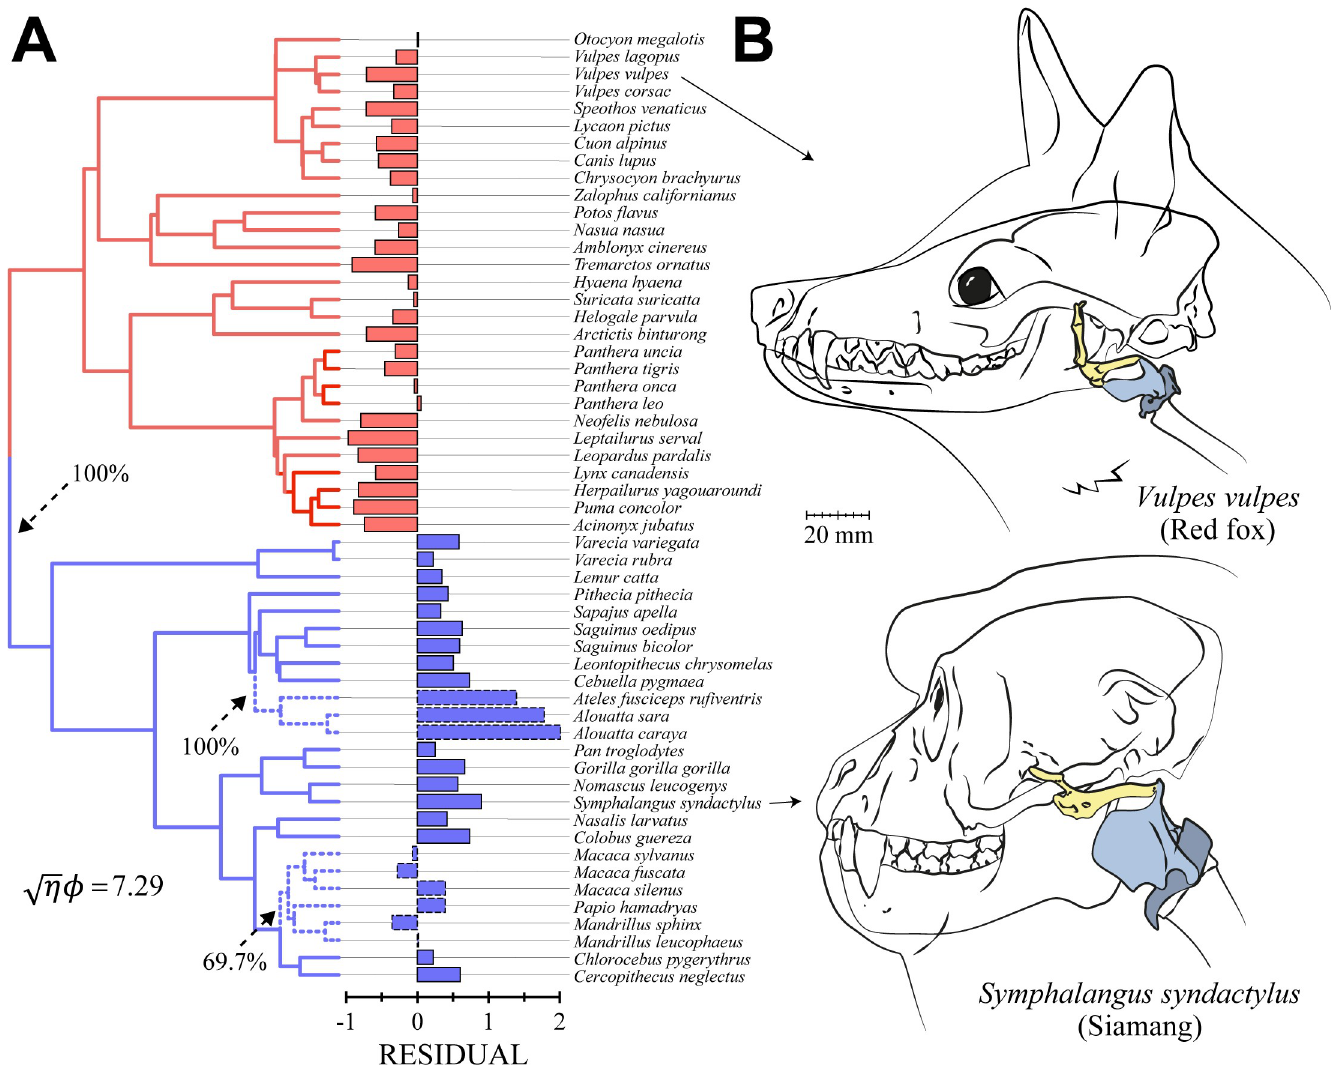
Fig 3. Ornstein-Uhlenbeck model results. (A) Phylogenetic tree and residuals from a pGLS regression of larynx size to log body-length. Carnivorans (red) exhibited smaller larynges than expected based on body size, whereas primates (blue) exhibited larger larynges. Among primates, atelids exhibited exceptionally large larynges (upper set of dashed lines), and papionines exhibited exceptionally small larynges (lower dashed lines). Arrows indicate where grade shifts in mean larynx size are estimated to have arisen; percentages indicate support for these estimations from a bootstrap analysis (see Methods). (B) Computer larynx models derived from CT scans depicted in situ for two species with comparable body lengths (71.4 cm for the red fox and 68.5 cm for the siamang), showing the larger relative size of the primate larynx. The data used to create this figure are located in S1 Data, sheet B, columns B and C. CT, computed tomography; pGLS, phylogenetic generalized least